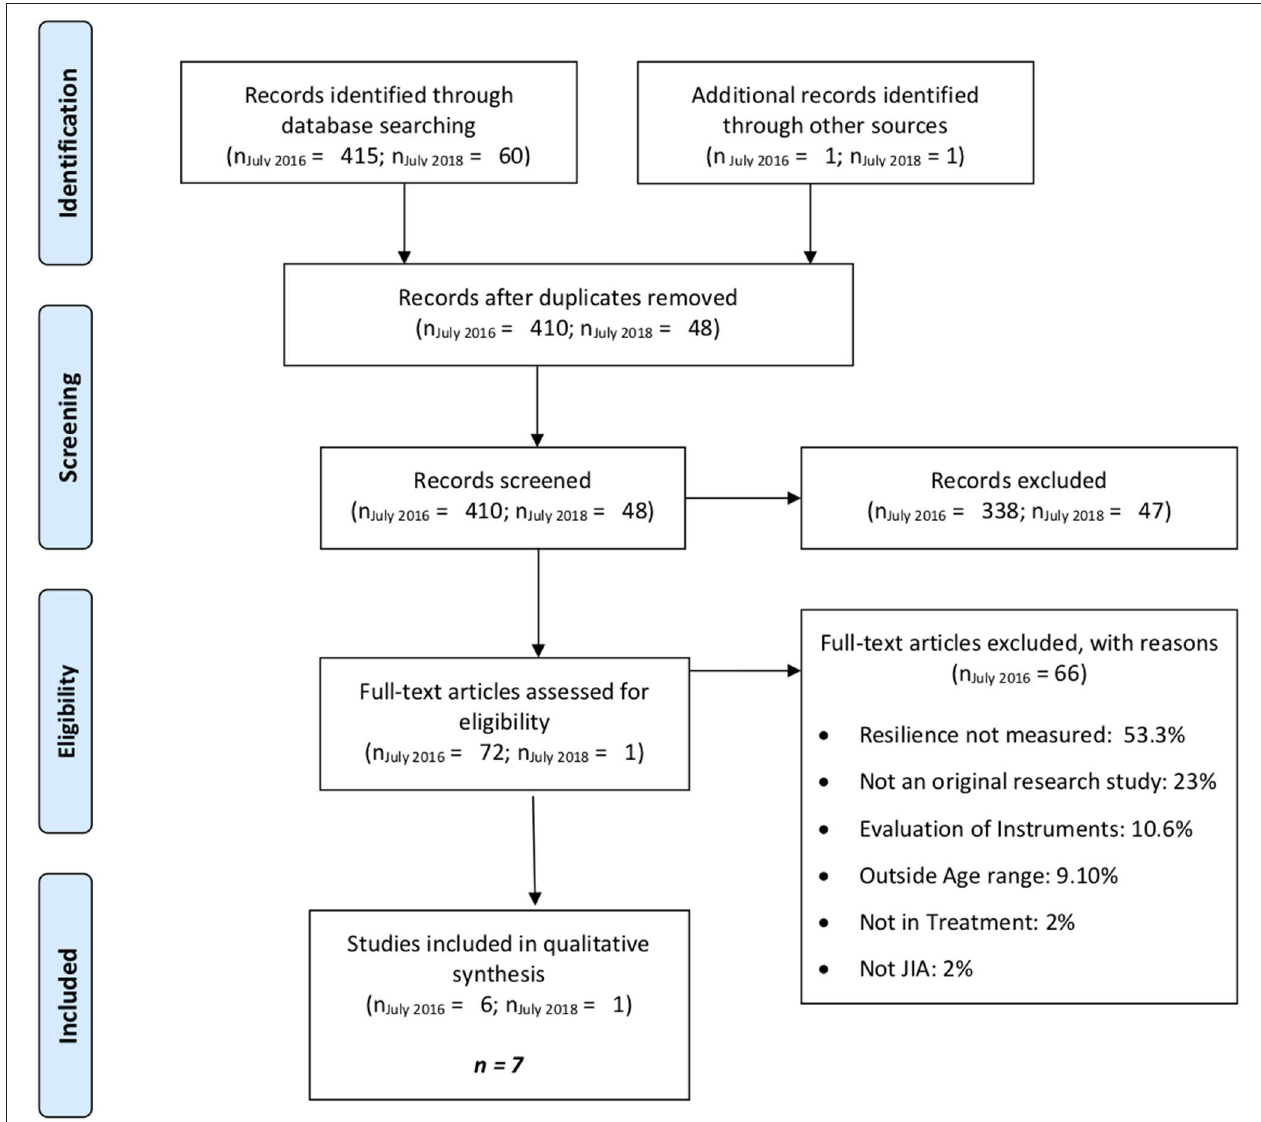
FIGURE 1 | PRISMA flow diagram of study